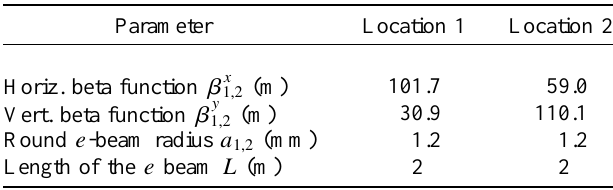
TABLE II. Bunch-to-bunch electron beam